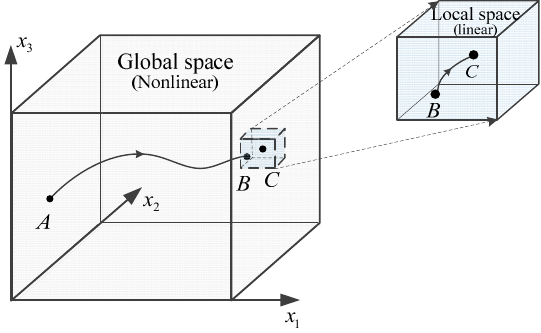
Figure 2. Geometric explanation for the multi-scale complexity.